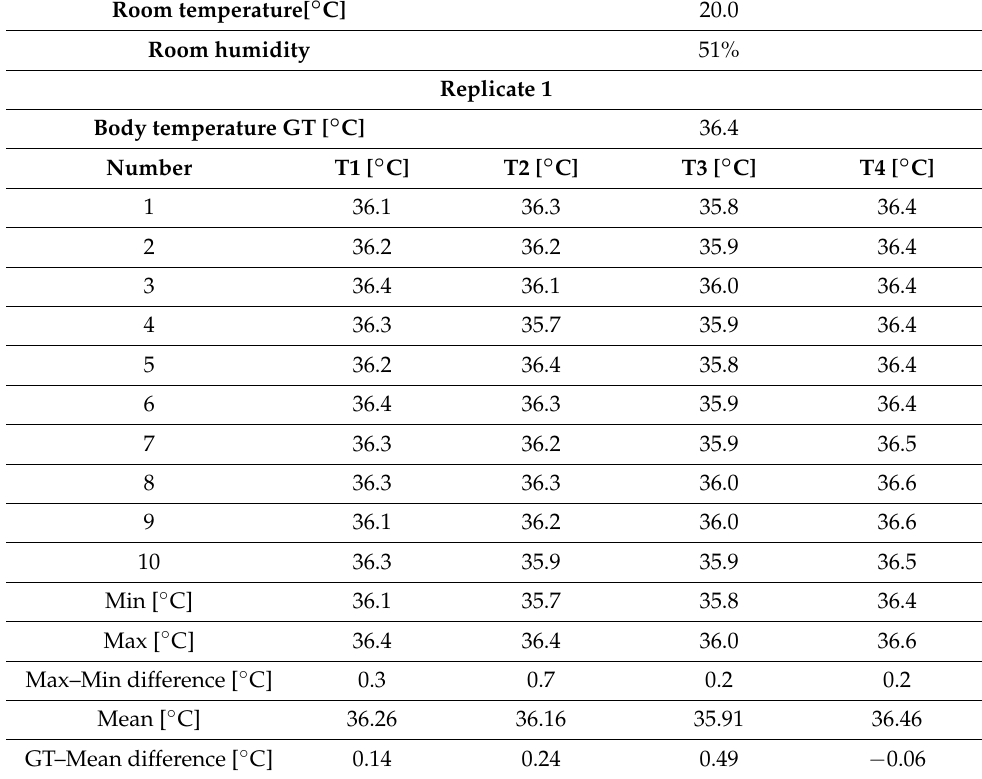
Table A3. Intra- and inter-rater reliability experiment. Subject 3 body temperature